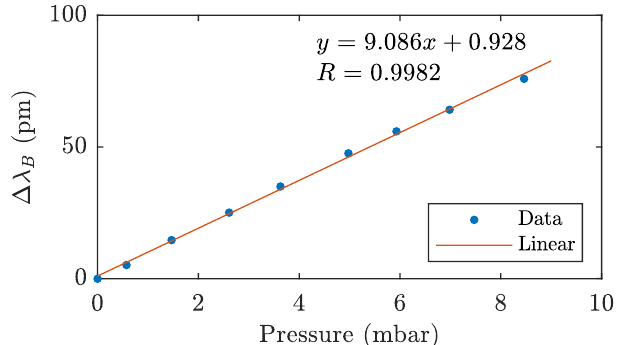
Figure 8. Calibration of the FBG pressure